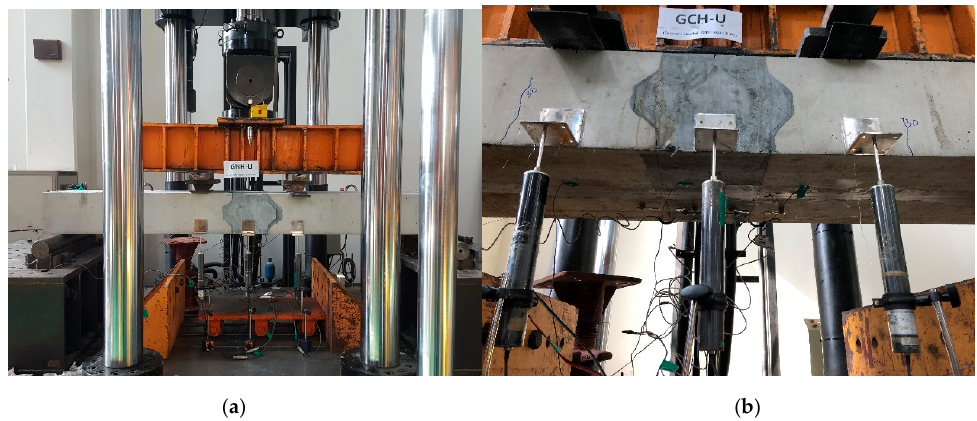
Figure 13. Test setup: ( a ) a photograph of the test setup and ( b ) a photograph of the measurement sensor (LVDTs).